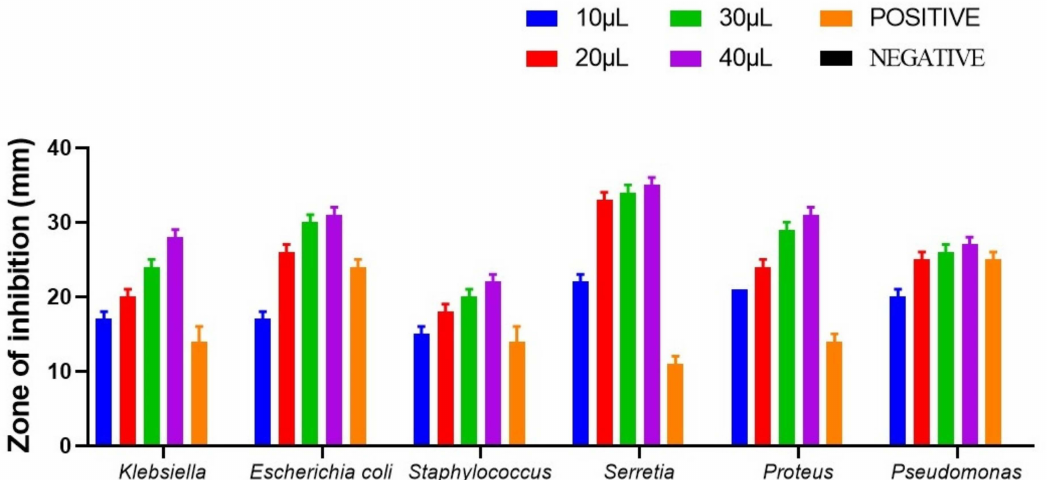
Figure 7. Graphical representation of the antimicrobial activity of the aqueous extract of Spirulina laxissima SV001 against different bacterial pathogens. p < 0.001, the two-way ANOVA was used for